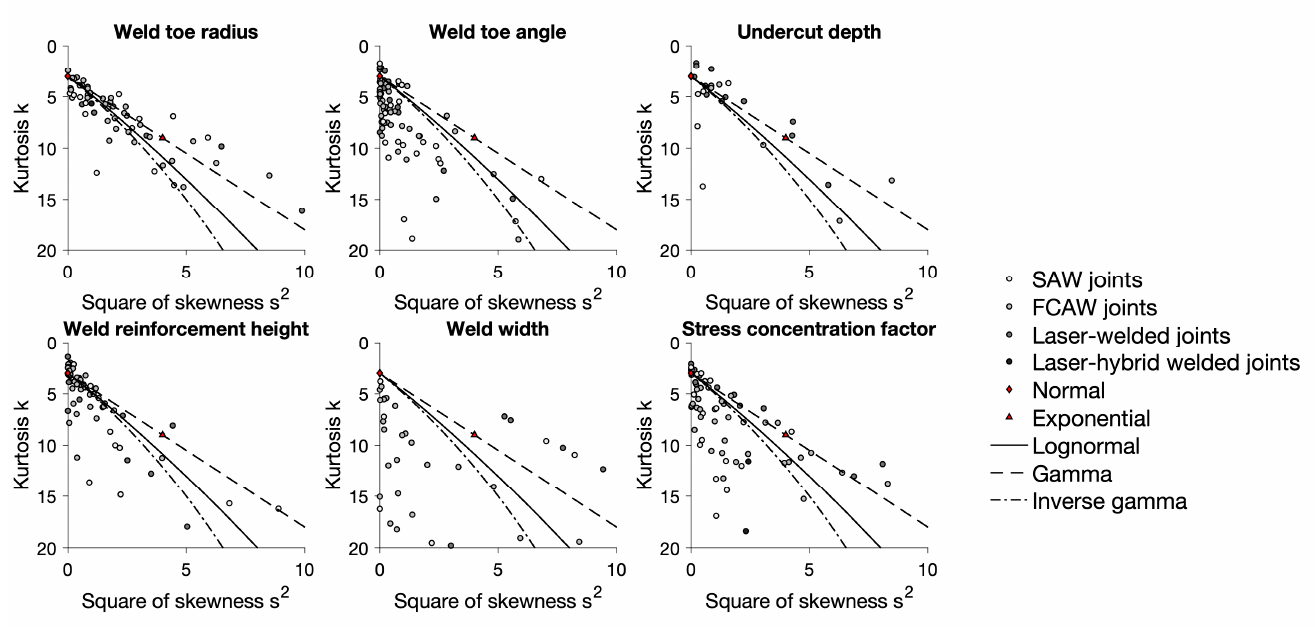
Figure 10. Skewness–kurtosis plot presenting the determined sample parameters and a number of common two ‐ parameter distribution functions.